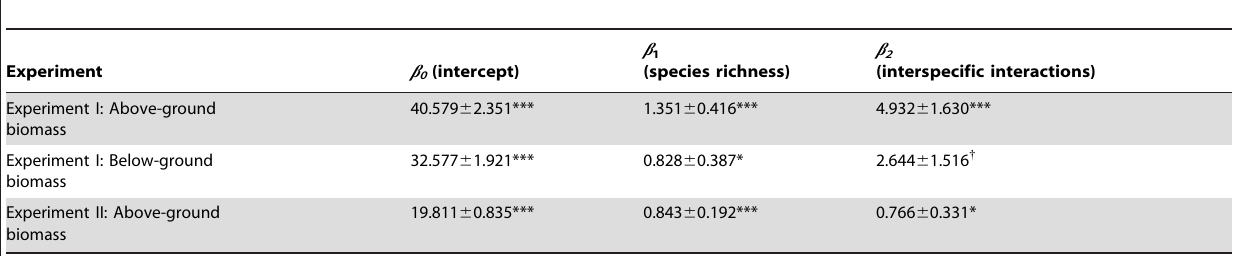
Table 1. Results of the mixed effects model for experiment I and of multiple regression model for experiment II for testing the effects of species richness and interspecific interactions on plot biomass for each experiment.